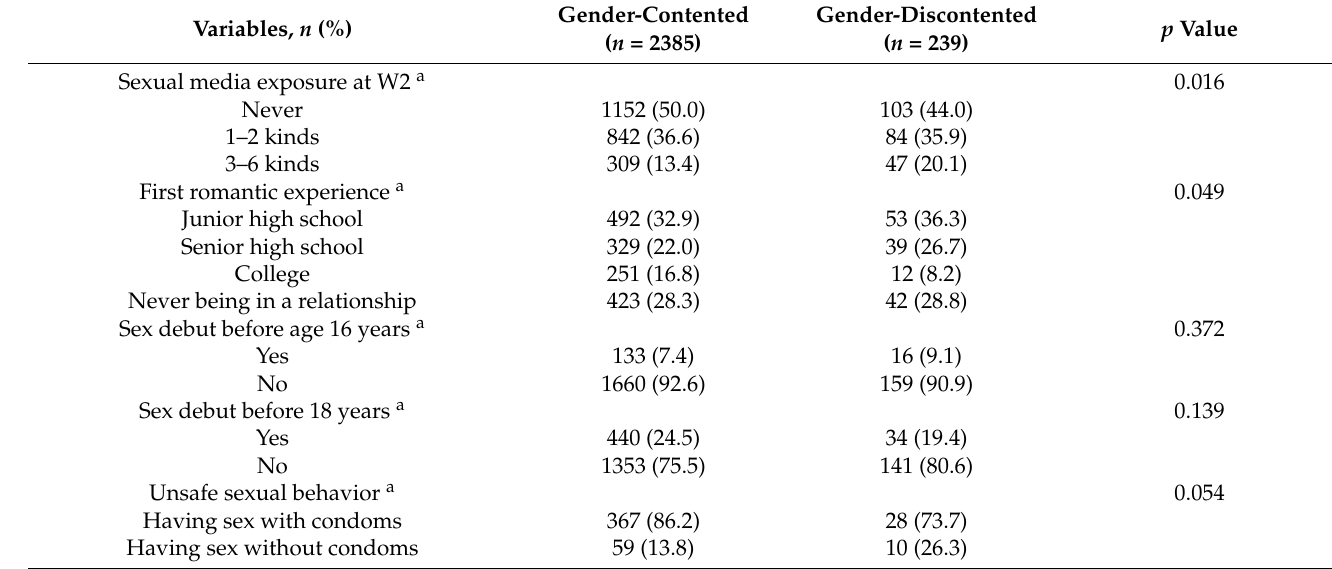
Table 2. Comparison of sex-related experiences between gender-satisfied and gender-dissatisfied adolescents.